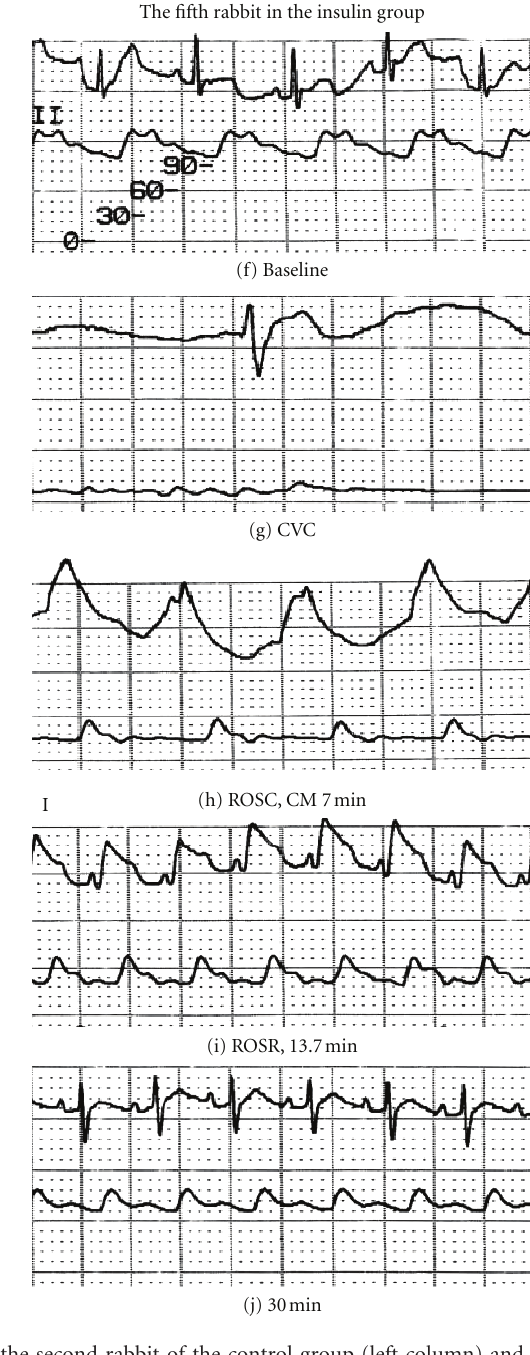
Figure 1: Sequential changes of ECG (upper) and ABP (lower) of the second rabbit of the control group (left column) and the fifth of the insulin group (right column), respectively. Lead II surface ECG was recorded at 25 mm/sec and 10mm/mV. In the second rabbit of the control group, (a) during the baseline period, the values were; HR, 152 bpm, and QRS, 40ms. (b) Bupivacaine injection caused sinus arrest and CVC. (c) At ROSC, CM stopped: HR, 205 bpm; QRS, 108 ms. (d) At ROSR: HR, 210 bpm; QRS, 82ms. (e) At 30 min after CVC: HR, 212bpm; QRS, 44 ms. In the fifth rabbit of the insulin group, (f) At baseline period: HR, 150 bpm; QRS, 48 ms. (g) Sinus arrest and CVC. (h) At ROSC, CM stopped: HR, 125bpm; QRS, 200 ms. (i) At ROSR: HR, 225 bpm; QRS, 68ms. (j) at 30 min after CVC: HR, 232 bpm; QRS, 48 ms. ECG: electrocardiogram; ABP: arterial blood pressure; bpm: beats per min; ms: millisecond; CVC: cardiovascular collapse; CM: cardiac massage; ROSC: return of spontaneous circulation; ROSR: return of sinus